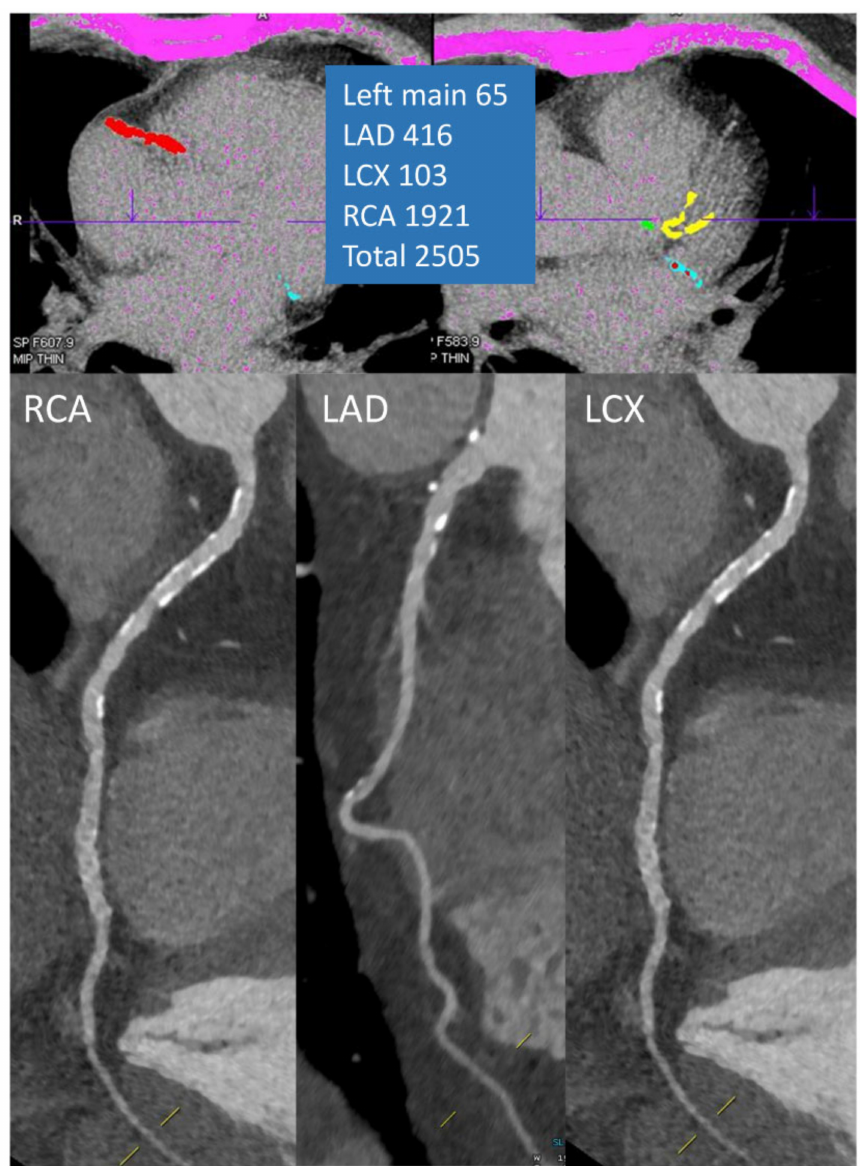
Figure 4. Excellent image quality in a patient with a very high CAC